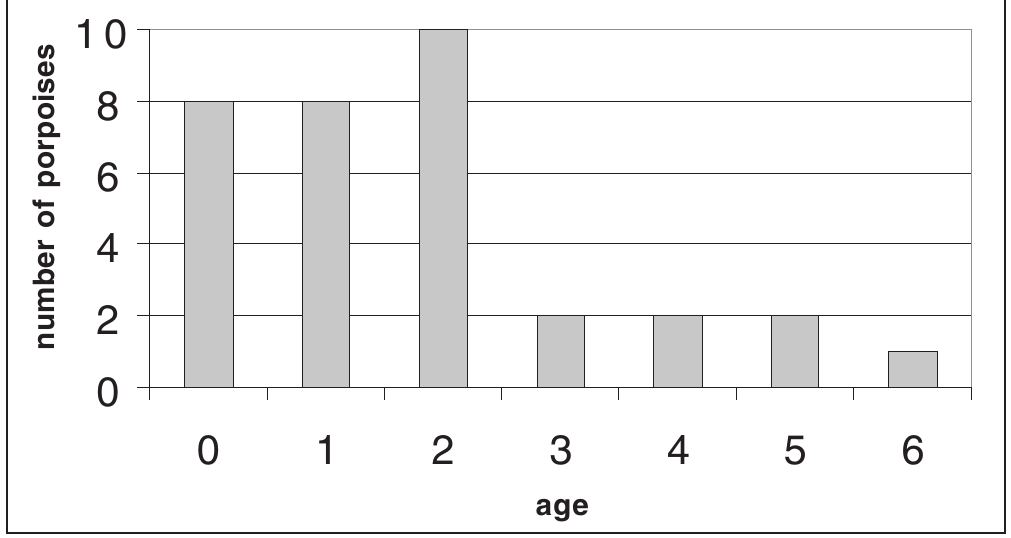
Fig. 6. Age distribution of harbour porpoises bycaught from